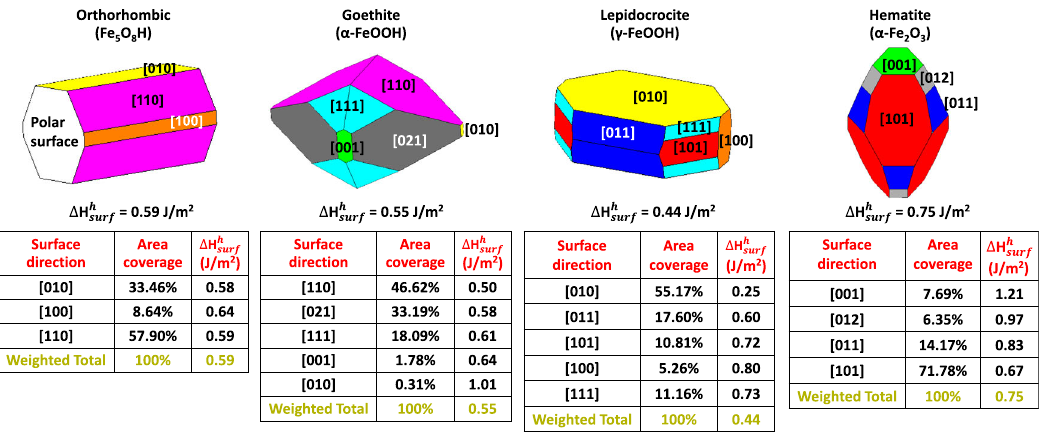
Fig. 4 Wulff representations and hydroxylated surface enthalpies of iron-(oxyhydr)oxide minerals. Morphology averaged surface enthalpies ( Δ H h surf ) of the mineral investigated. The surface enthalpies of the two ferrihydrite models have been assumed to vary between 0.10 and 0.40 J/m